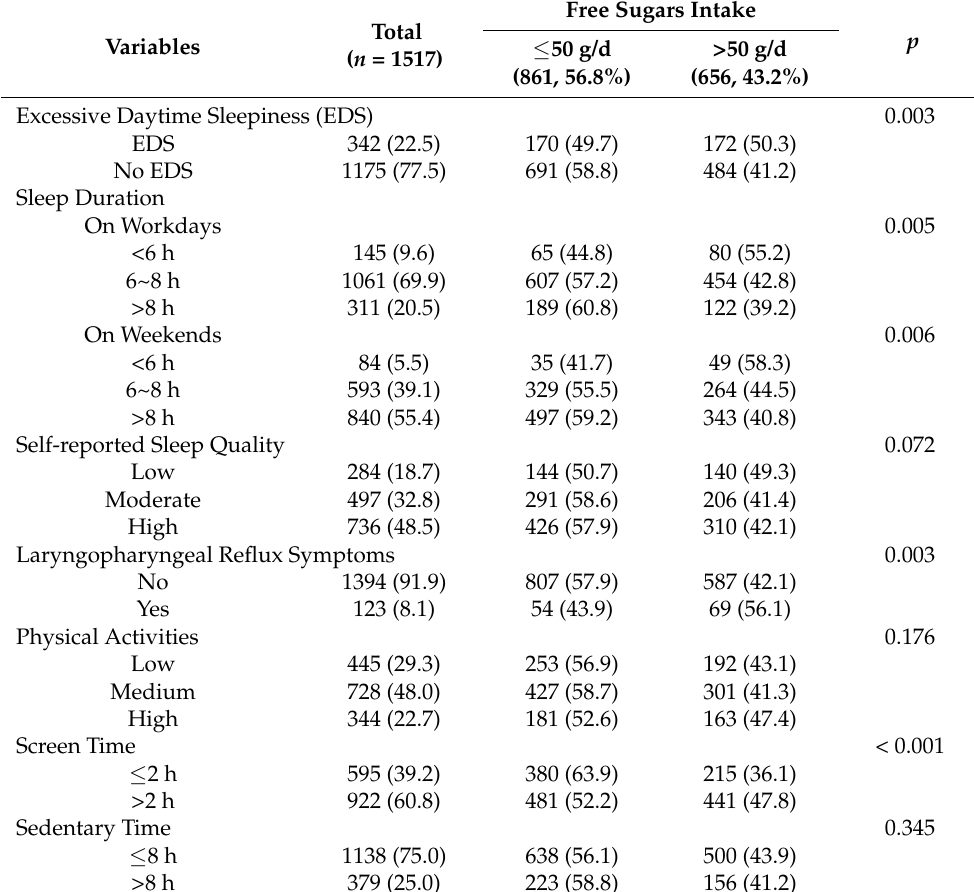
Table 2. EDS Related Factors by the level of free sugars intake ( n = 1517